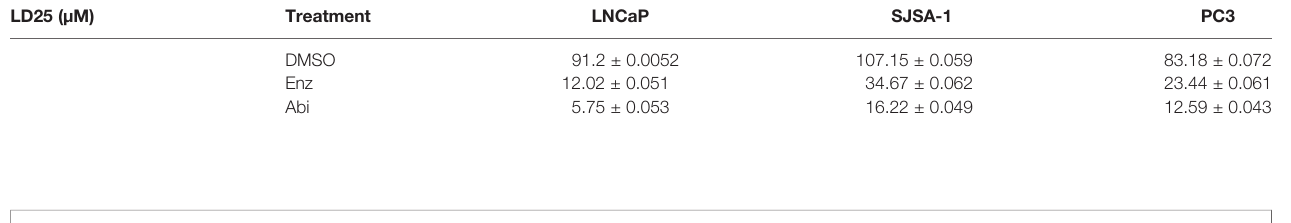
TABLE 1 | LD25 values of MTT values across cell lines ± SEM. LD25 values were determined from MTT curves and indicate the drug concentration at which cell viability was reduced by 25%. LD25